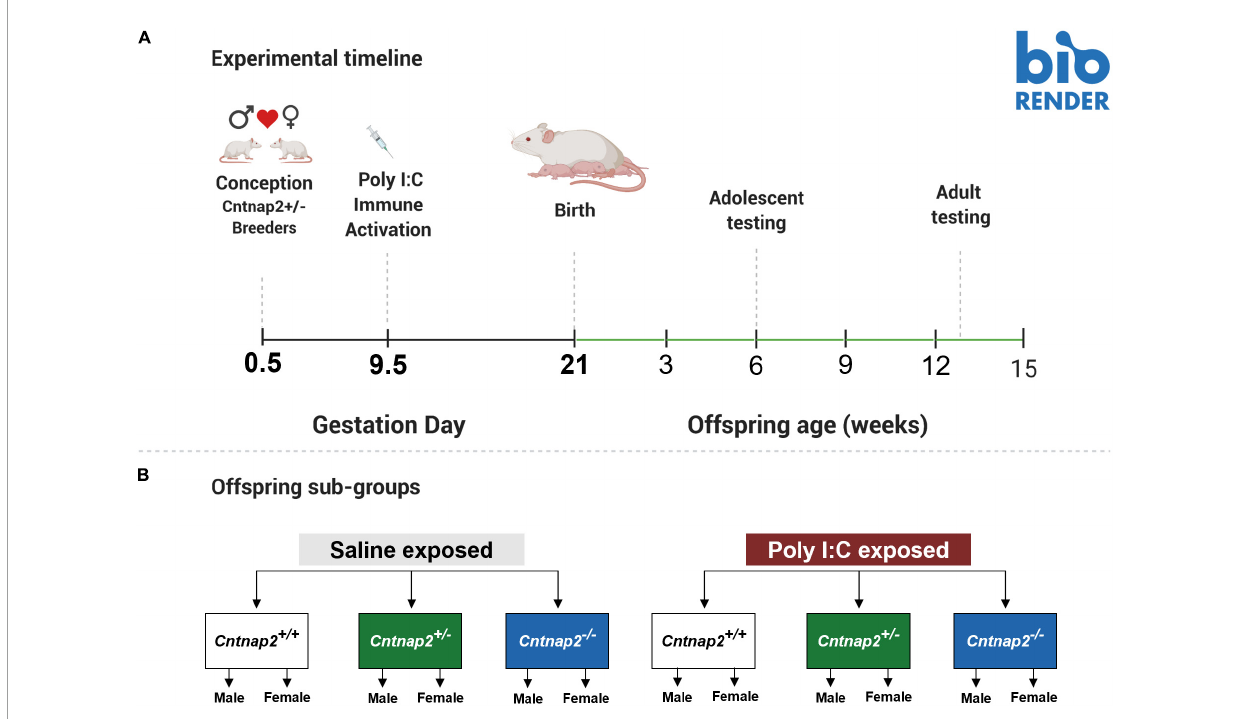
FIGURE1 Summary of experimental timeline and groups. (A) Illustration showing the experimental timeline, including the timing of MIA and behavioral experiments. (B) A schematic showing the different MIA and genotype subgroups. There were 6 MIA-genotype groups, and 12 total subgroups when accounting for